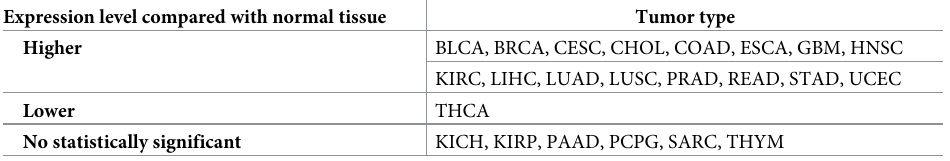
Table 1. The expression level of CALR in tumors analysis compared with normal tissue by UALCAN database.